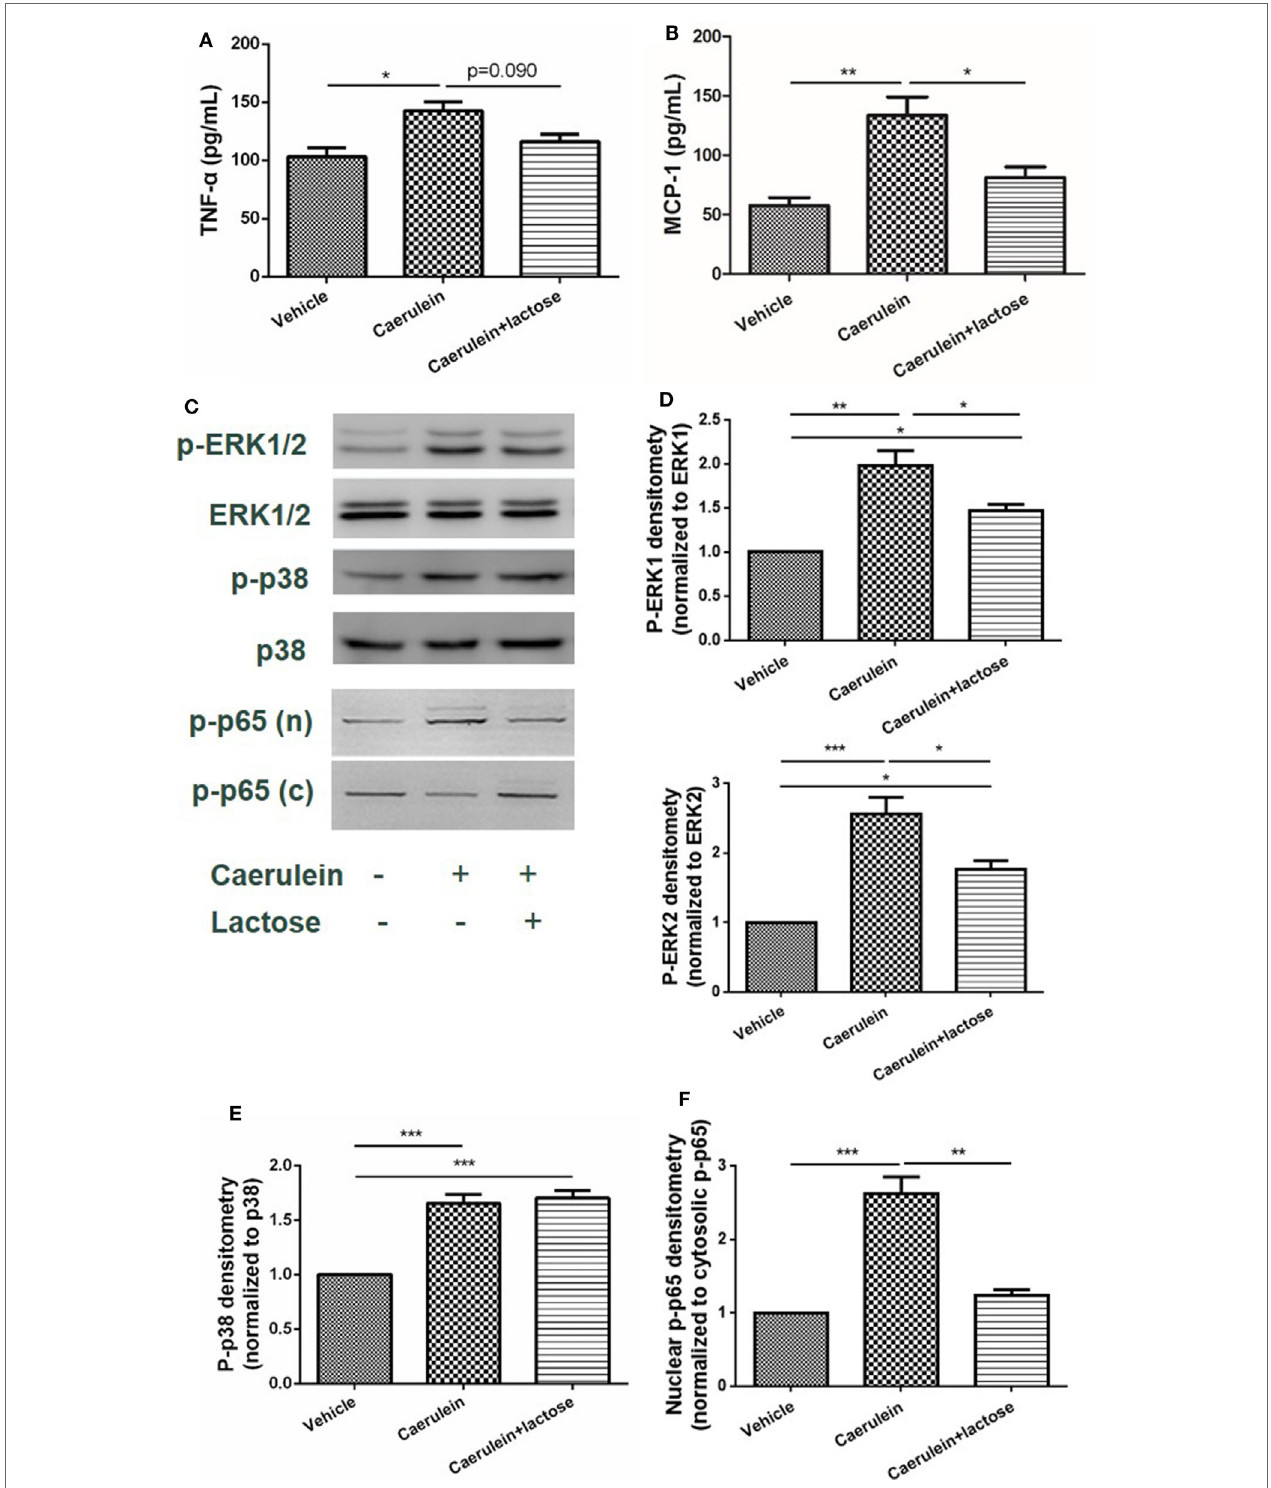
FigUre 5 | Lactose attenuates caerulein-induced cytokine/chemokine production and p-extracellular signal-regulated kinases(ERK)1/2-NF- κ B p65 signaling pathway activation in pancreatic acinar cells. Acinar cells were isolated from fresh pancreas and treated with caerulein (10 − 7 M) together with or without 0.5 mM lactose. Shown are the levels of tumor necrosis factor alpha (a) and monocyte chemotactic protein-1 (B) production by ELISA and Western blot analysis (c) of p-ERK1/2, ERK1/2, p-p38, p38, nuclear (n), and cytosolic (c) p-NF- κ B p65 and densitometry analysis (D–F) . Results are mean ± SEM from at least three independent experiments of at least three independent mice in each group. * p < 0.05, ** p < 0.01 *** p < 0.001 by one-way analysis of